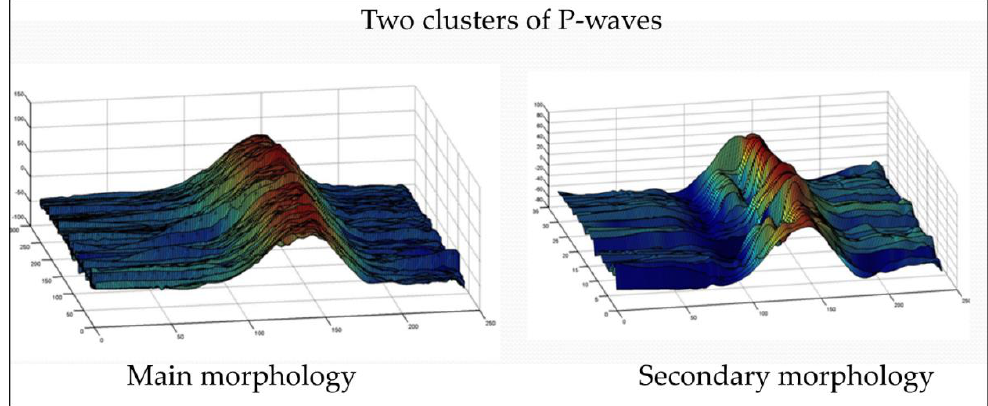
Figure A8. Beat-to-beat allocation of P-waves to main or secondary morphology.